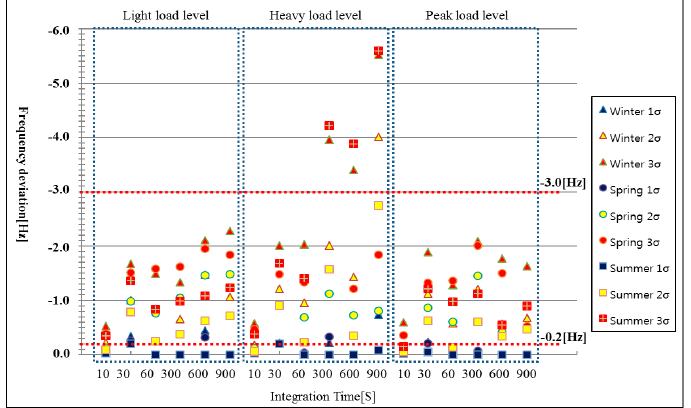
Figure 14. Frequency deviation distribution chart of the group of companies (business model).